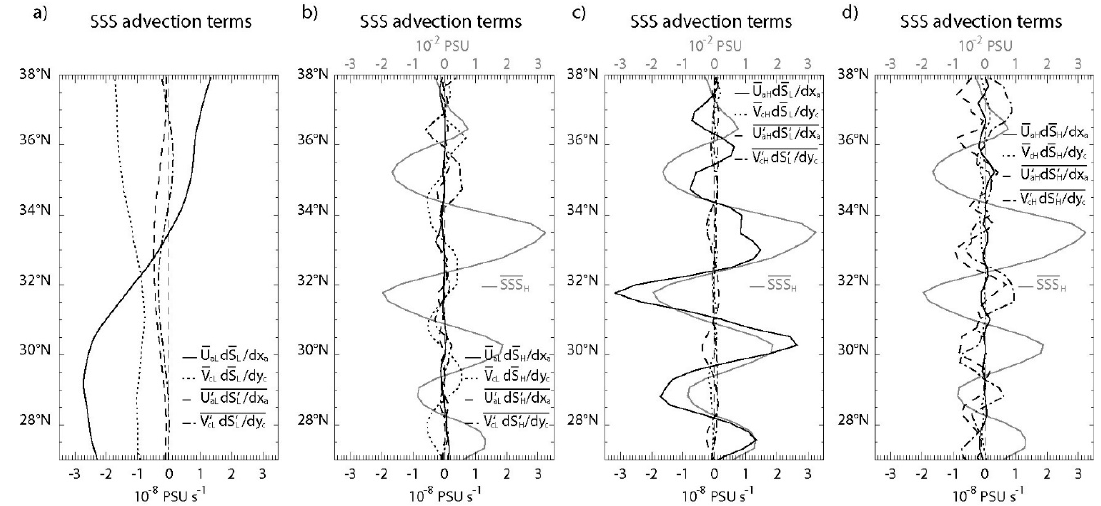
Figure 9. Same as Figure 8, except for the SSS advection terms and mean spatially high-pass filtered SSS, averaged quasi-zonally within the tilted solid box on Figure 7c,d.